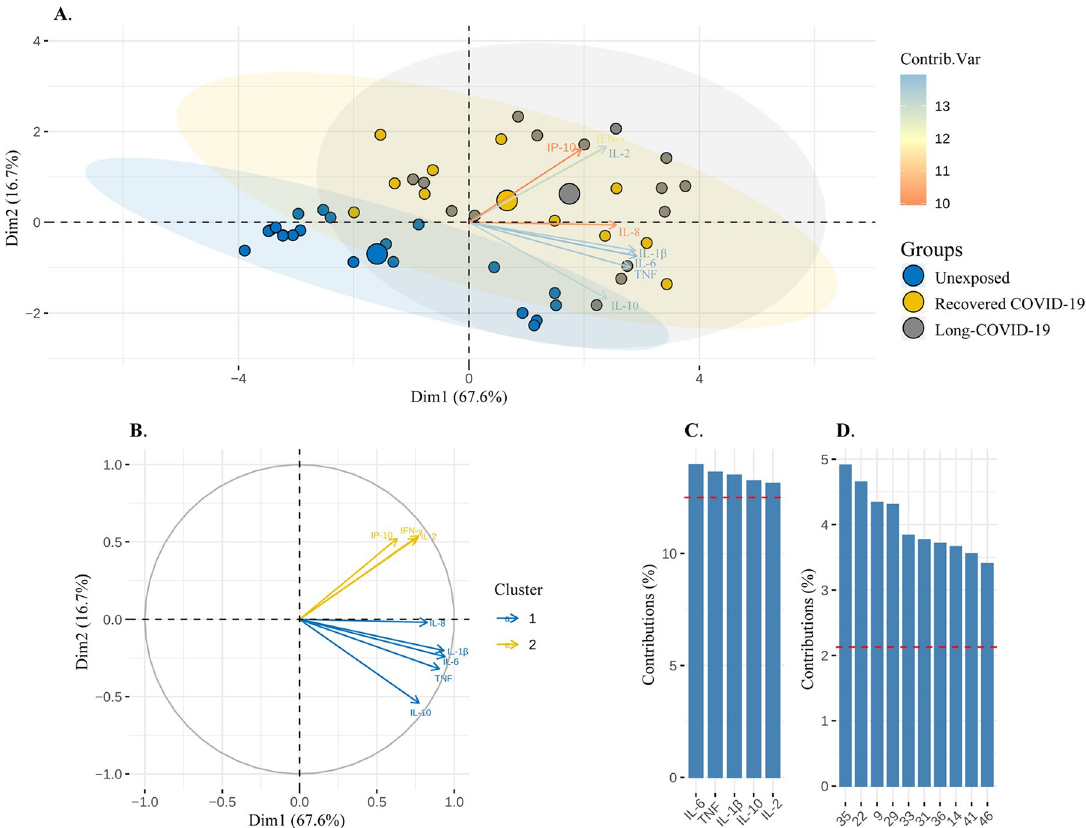
Fig 5. Principal component analysis (PCA) discriminates cytokines between COVID-19 and healthy unexposed groups. Analysis of variance of cytokine concentrations IFN- γ , TNF, IL-1 β , IL-2, IL-6, IL-8, IP-10, IL-12, IL-4, IL-10, and IL-17A were evaluated for COVID-19 patients (N = 26) and unexposed healthy volunteers (N = 21). (A) A 2D representation, given by the first two principal components with 67.6% and 16.7% explained variance (84.3% cumulative percentage explained), of Unexposed (blue solid circles), Recovered COVID-19 (yellow solid circles) and Long COVID-19(gray solid circles), with point sizes proportional to the average individual contribution to any principal component. The variables (biomarkers) are expressed by colored vectors, indicating their average contribution to the principal components. (B) A representation where the vector represents the correlation between a variable (biomarker) and a principal component (PC) is used as the coordinates of the variable in the PC. The variables are colored according to the results of a divisive clustering of k-means (k = 2). (C) Bar graph indicating the seven variables (biomarkers) according to their average contribution to each main component. (D) Bar graph indicating the top 10 individuals according to their average contribution to any major